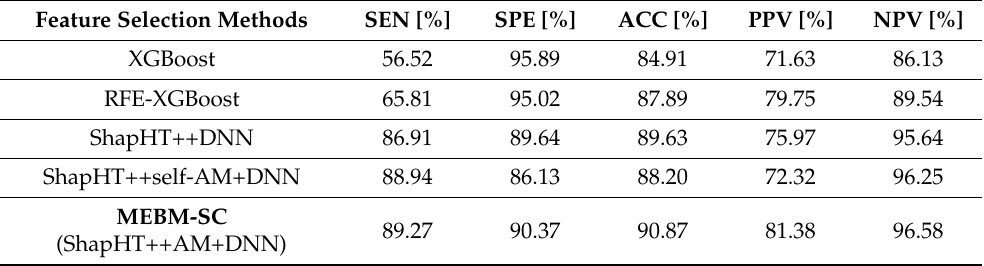
Table 7. The ablation study shows the effectiveness of the feature selection method and classifier with other methods.